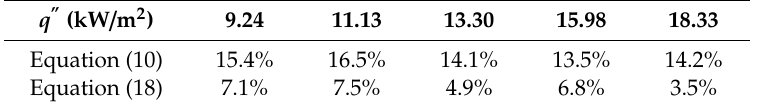
Table 4. MREsof the local heat transfer coe ffi cients calculated by Equations (10) and